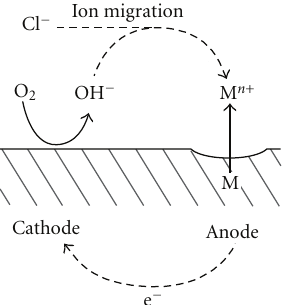
Figure 2: Idealized crevice, showing the transformation and migra- tion of